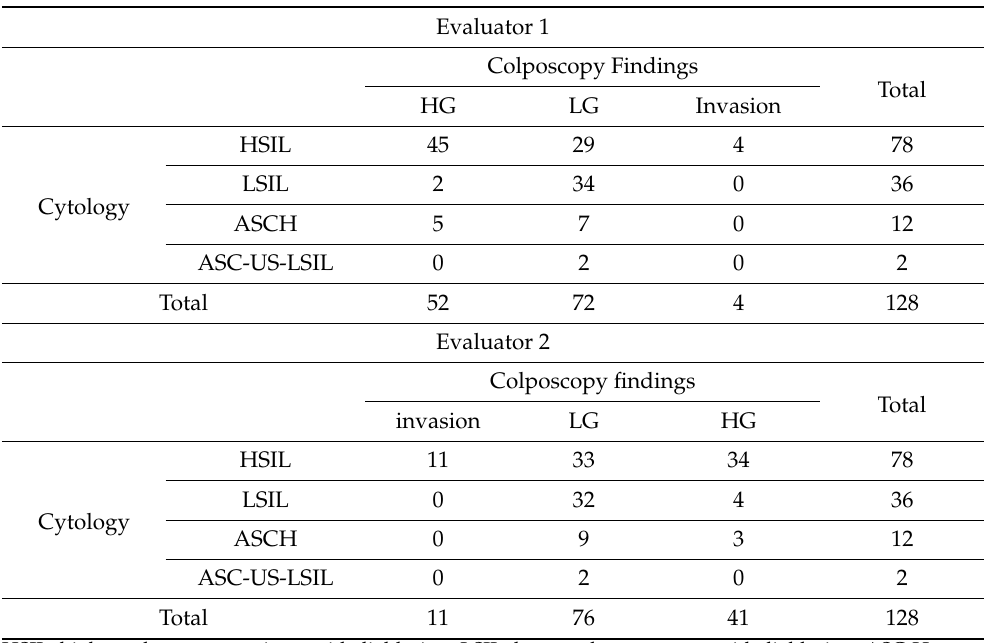
Table 1. Correspondence between colposcopic findings and cytology results obtained by evalua- tors 1 and 2.